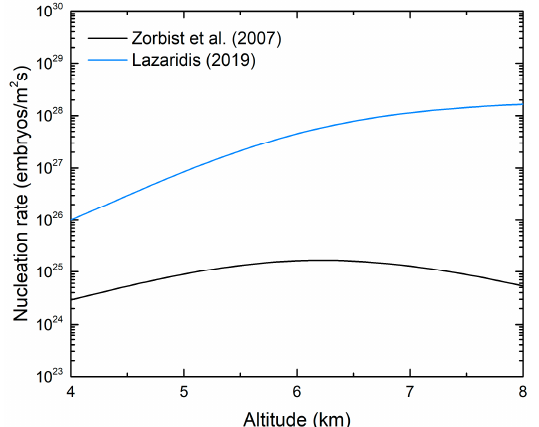
Figure 5. Ice nucleation rate (embryos m − 2 s − 1 ) for immersion freezing versus altitude (bacteria radius equal to 0.3 μ m, θ = 20°) using two different approaches for calculating the activation diffusion [24].